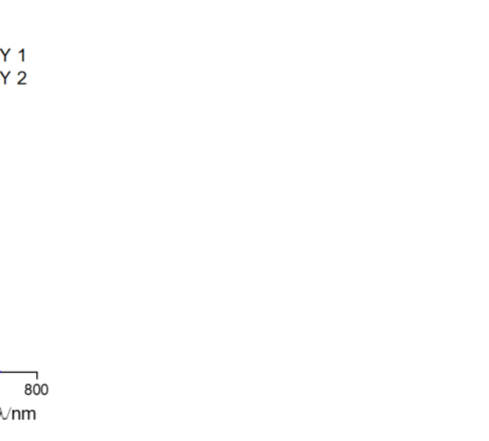
Figure 6. Absorption spectra of BODIPY 1 (Blue line) and BODIPY 2 (Black line) anchored on TiO 2 .